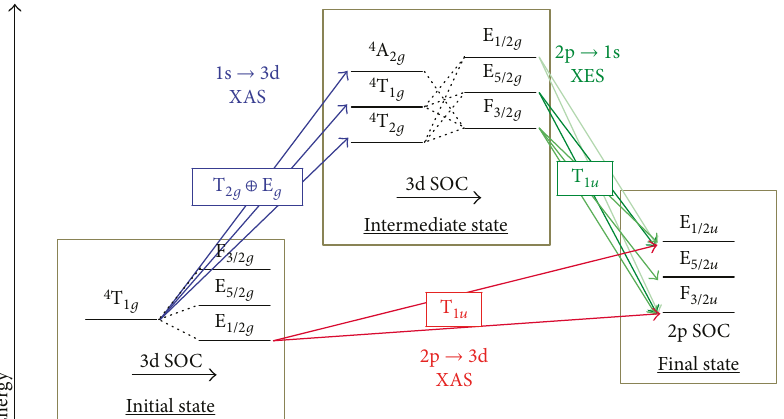
Figure 51: Multielectronic term scheme for Co 2+ (3d 7 ) in high spin comparing the 1s2p RIXS and direct 2p XAS pathways. Also, the spin multiplicity was omitted where the spin-orbit interaction is included.